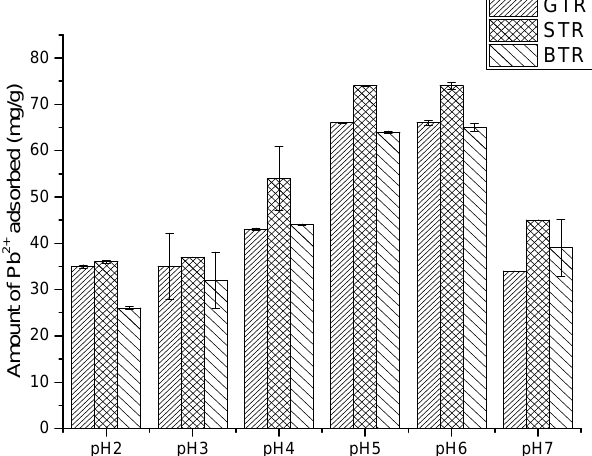
Figure 5. Effects of pH on the Pb 2+ adsorption on the resins at an initial concentration of 100 ppm and powder resin concentration of 0.5 g/L (particle size + 100 µ m; agitation rate: 120 rpm; contact time: 180 min). Values are expressed as mean ± SD. Table 2. Effects of temperature on the Pb 2+ adsorption on the resins at an initial concentration of 100